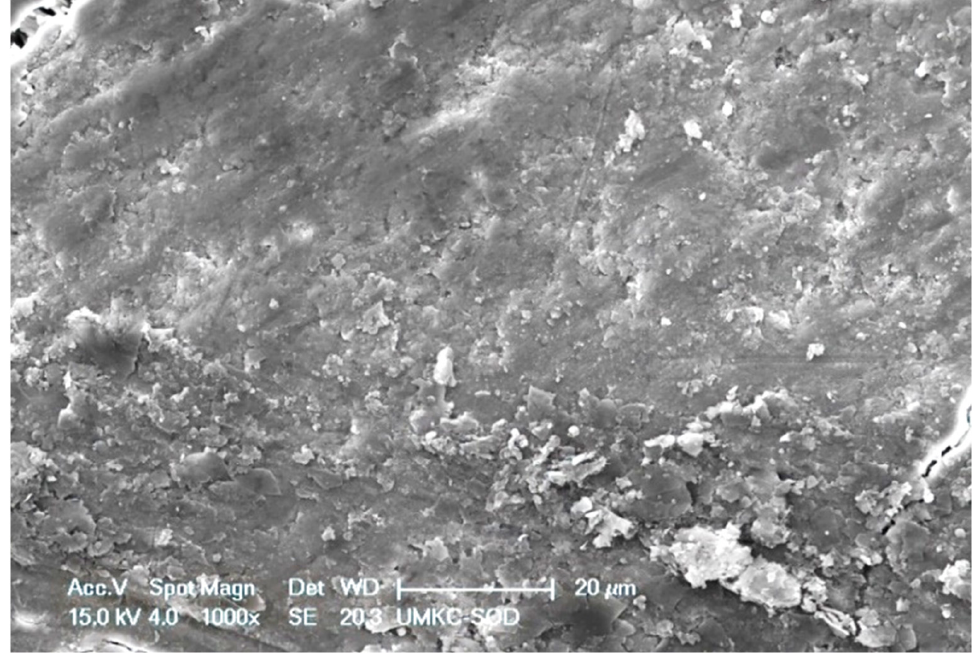
Figure 4. SRP-only treated specimen characterized by a smear layer consisting of loosely attached debris and a parallel pattern of instrumentation streaks. Original magnification of 1000×; Bar = 20 μ m.